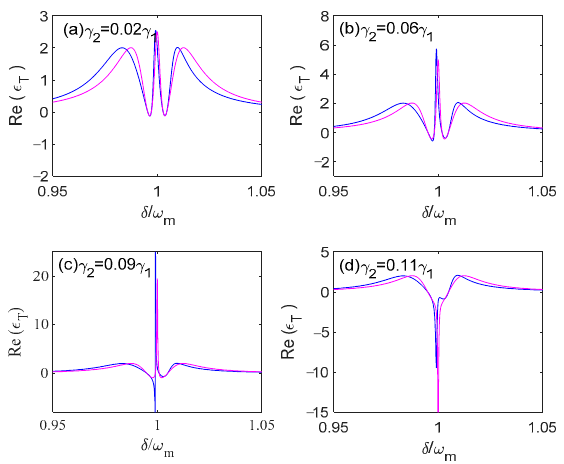
Figure 3. The real part ( χ = 3 × 10 − 9 γ 1 , blue line) and the real part ( χ = 0, pink line) of the output filed as a function of the probe detuning δ with different γ 2 . ( a ) γ 2 = 0.02 γ 1 ; ( b ) γ 2 = 0.06 γ 1 ; ( c ) γ 2 = 0.09 γ 1 ; ( d ) γ 2 = 0.11 γ 1 . ( g 1 = 0, J 2 = 0.095 γ 1 , and the other parameter values are the same as in Figure 2).